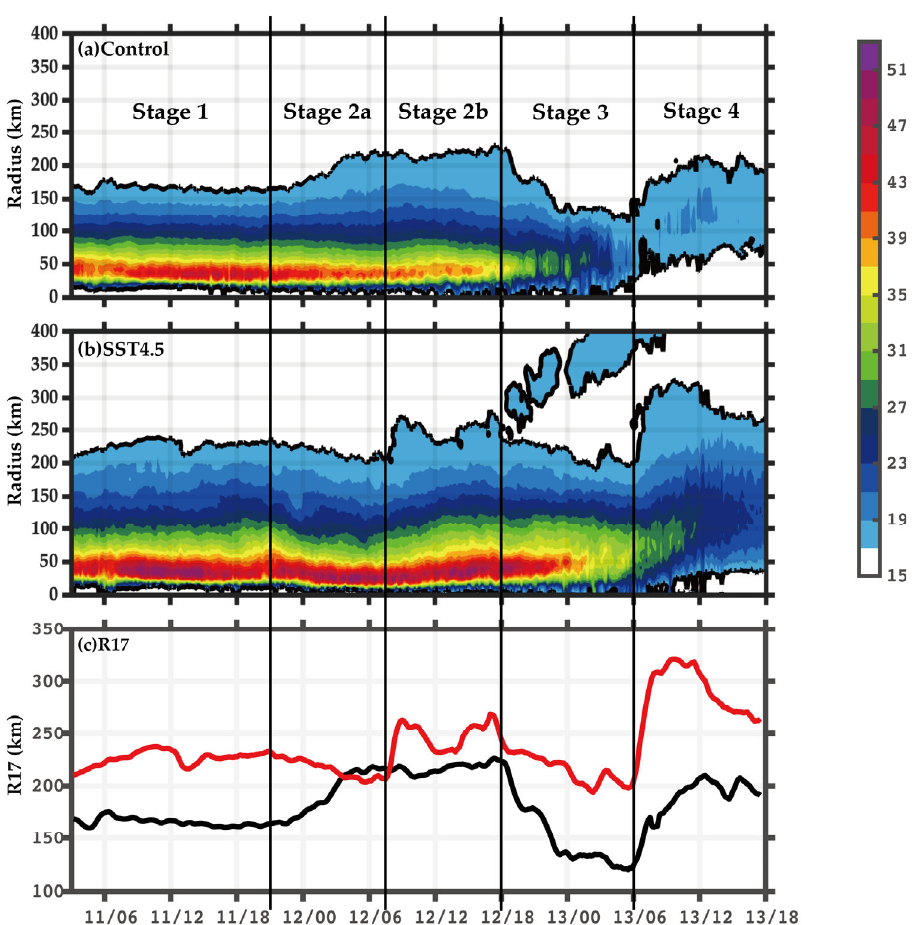
Figure 3. Horizontal wind speed (shaded; m s − 1 ) at the 10 m level in ( a ) the control and ( b ) SST4.5. The vertical axes show the distance (km) from the storm center. ( c ) Radius of the 10 m wind speed 17 m s − 1 (R17; km; 1 h running mean) in the control (black solid lines) and SST4.5 (red solid lines). The D3 output is utilized (10 min interval). Different stages of cyclone size evolution are separated by thin vertical lines. Stage 1 was before ET or just beginning ET; in stage 2, the cyclone size increased